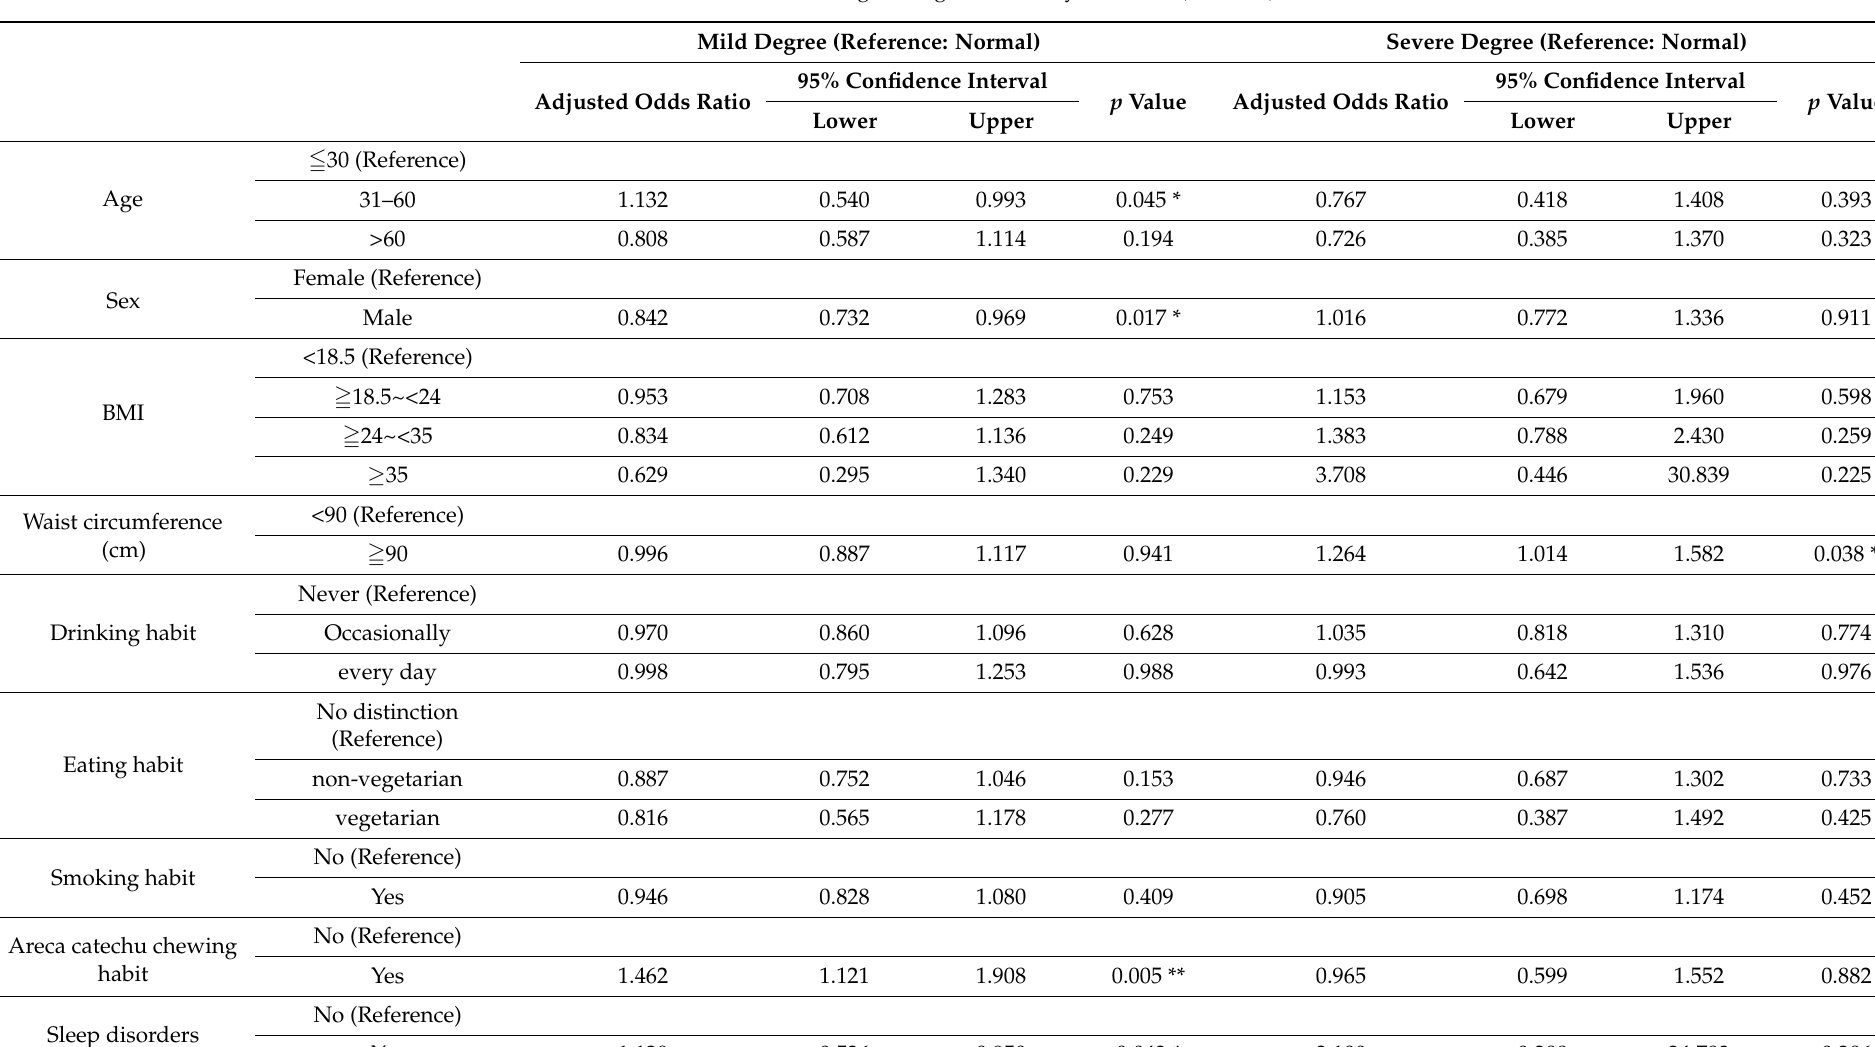
Table 2. Multivariate logistic regression analysis results ( n =